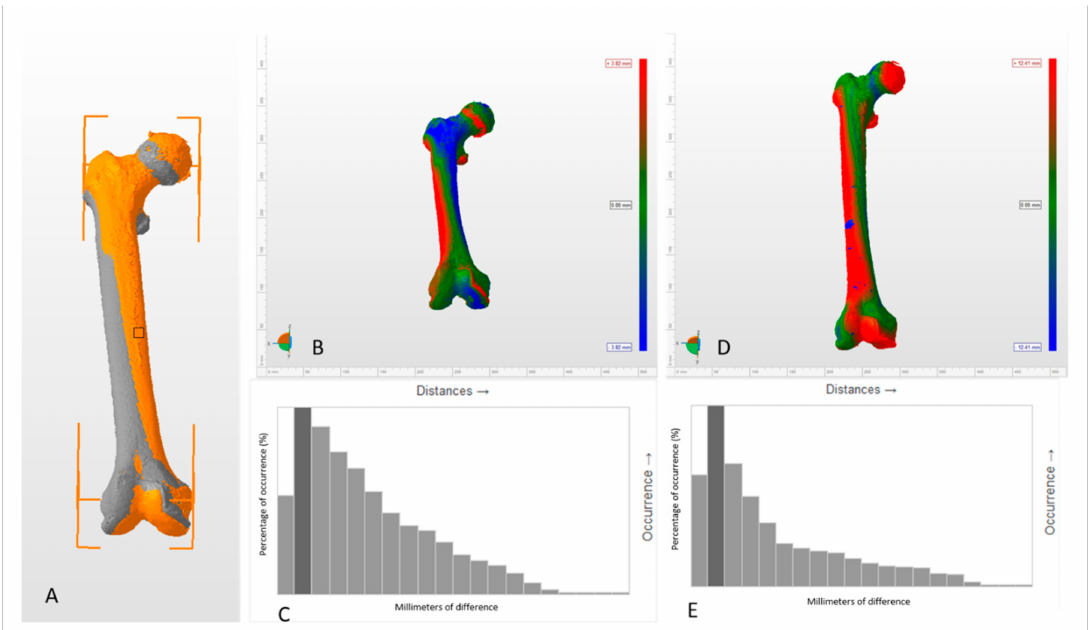
Figure 6. Changes in asymmetry pattern between manual and automatic alignment methods (Autodesk Netfabb 2019, Autodesk, California CA, USA). ( A ) General view of both femurs manually aligned. The right femur is in grey and the left femur is in orange, both overlapped. ( B ) Asymmetry pattern between two femurs manually aligned. The di ff erences between both femurs are represented in a color code that is referenced in the lateral bar. The intensity of the blue and red colors represents the magnitude of the positive and negative di ff erences between both femurs, respectively. The green color represents the absence of di ff erences. ( C ) Histogram of the behavior of the di ff erences between two femurs manually aligned. ( D ) Asymmetry pattern between two femurs automatically